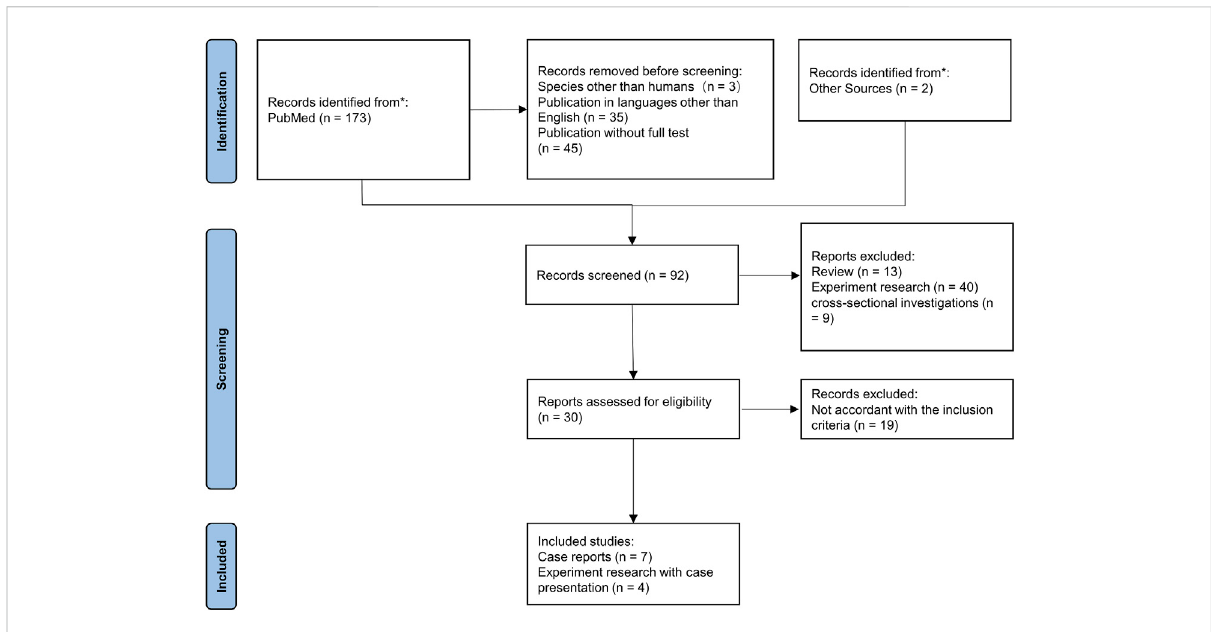
FIGURE 4 PRISMA fl owchart for the systematic literature review. Inclusion and exclusion of references are shown.